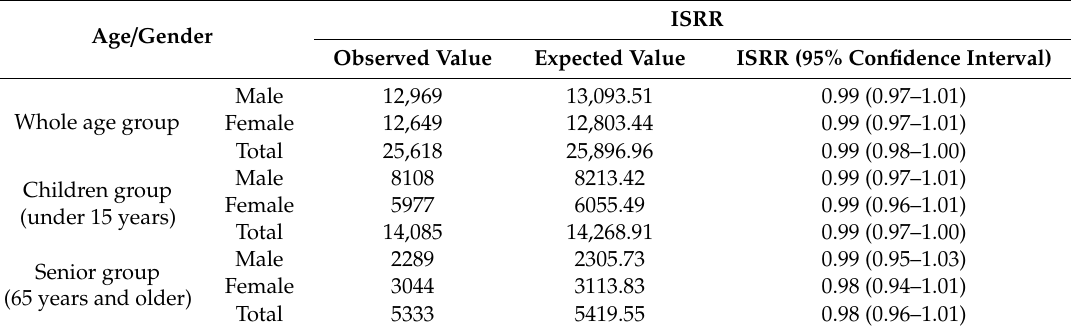
Table 2. Age-specific and gender-specific indirectly standardized relative risk (ISRR) in Seoul. ISRR Age / Gender Observed Value Expected Value ISRR (95% Confidence